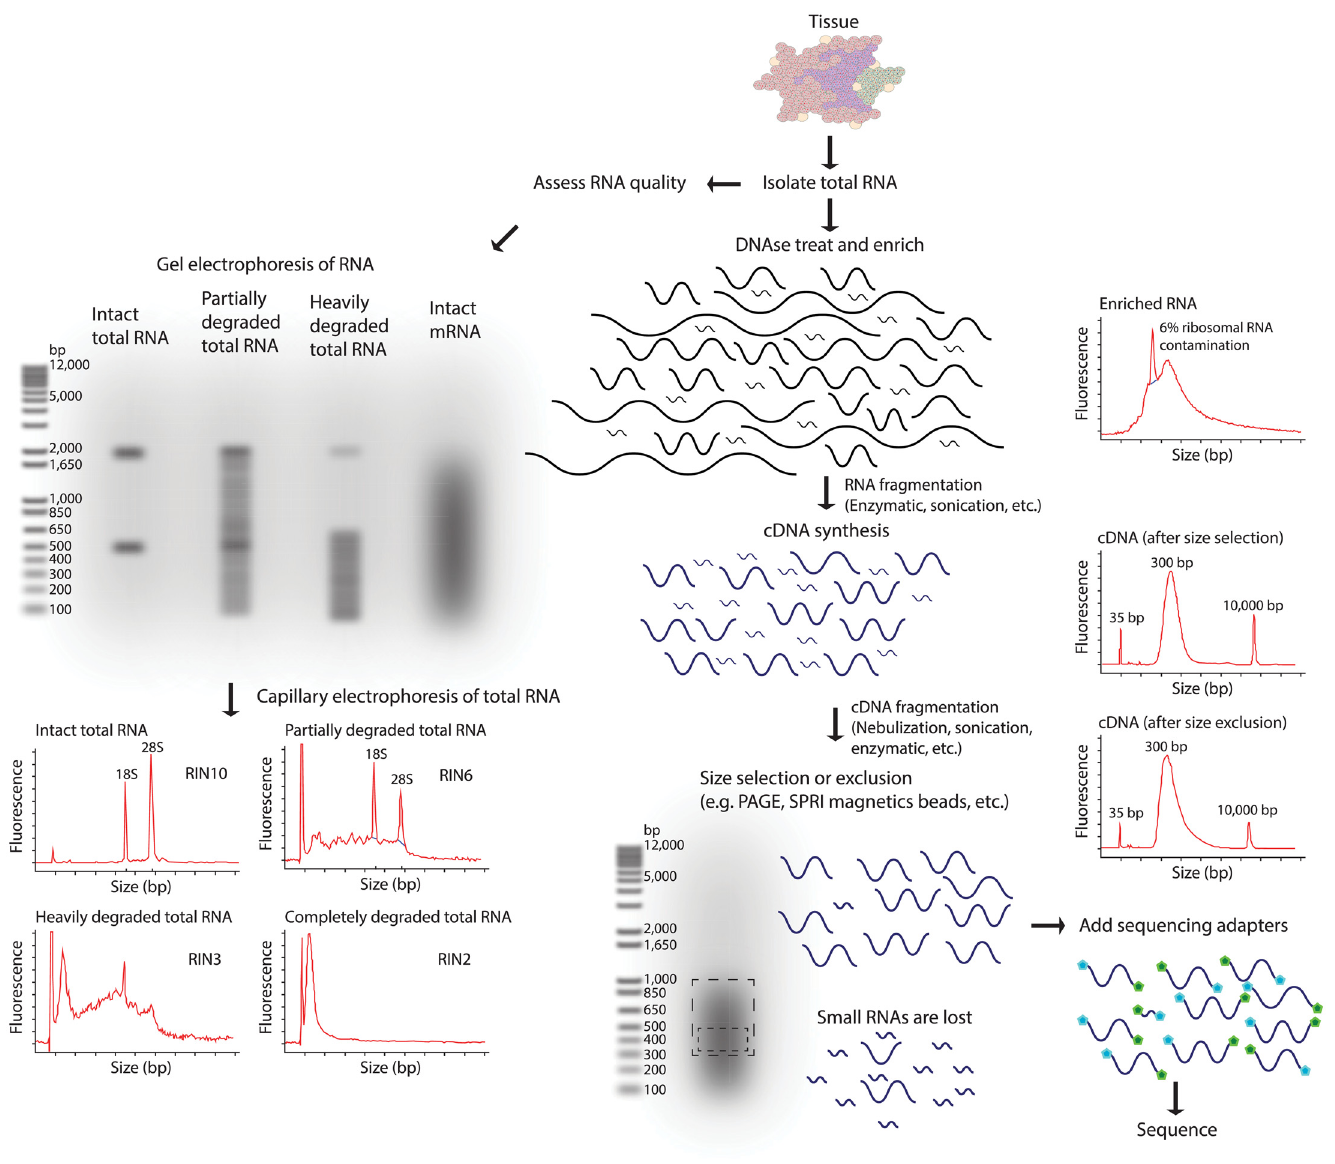
Fig 3. RNA-seq library fragmentation and size selection strategies that influence interpretation and analysis. RNA-seq library construction may involve both fragmentation and size selection. These procedures may be modified according to the integrity and amount of starting total RNA. The distributions of RNA molecule sizes are depicted for input total RNA and at various stages during the process of RNA/cDNA fragmentation and size selection. Commonly used methods for fragmentation and size selection are depicted along with the expected output of a quality-control assay at each stage (in the form of a capillary electrophoresis trace). Note that in the final library, it is typical that the majority of RNAs below a certain size (typically < 150 – 200 bp) are underrepresented. Refer to S3 Table and S7 Table for more details on many of the concepts depicted in this